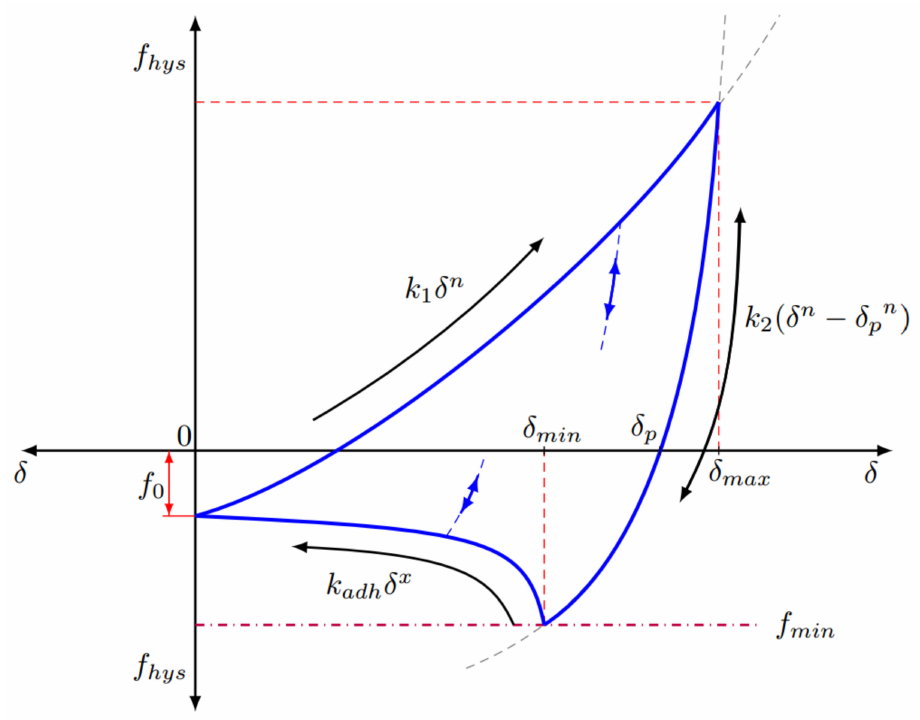
Figure 4. Force–displacement behaviour of the Edinburgh Elasto-Plastic Adhesion